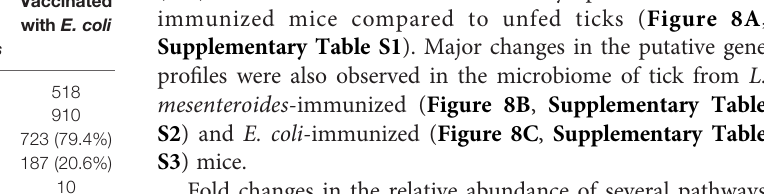
TABLE 1 | Topological parameters of co-occurrence networks. Network features